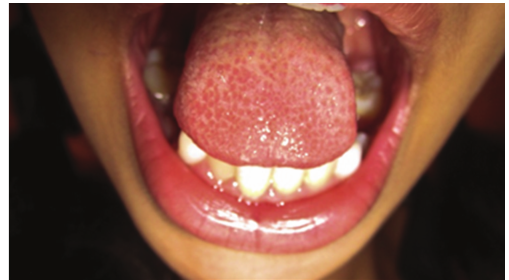
F 7: Postoperative photograph aer 1 year (Case 1).